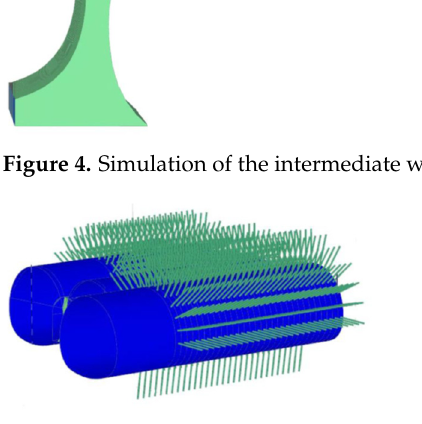
Figure 5. Simulation of the rock bolts using embedded beams.